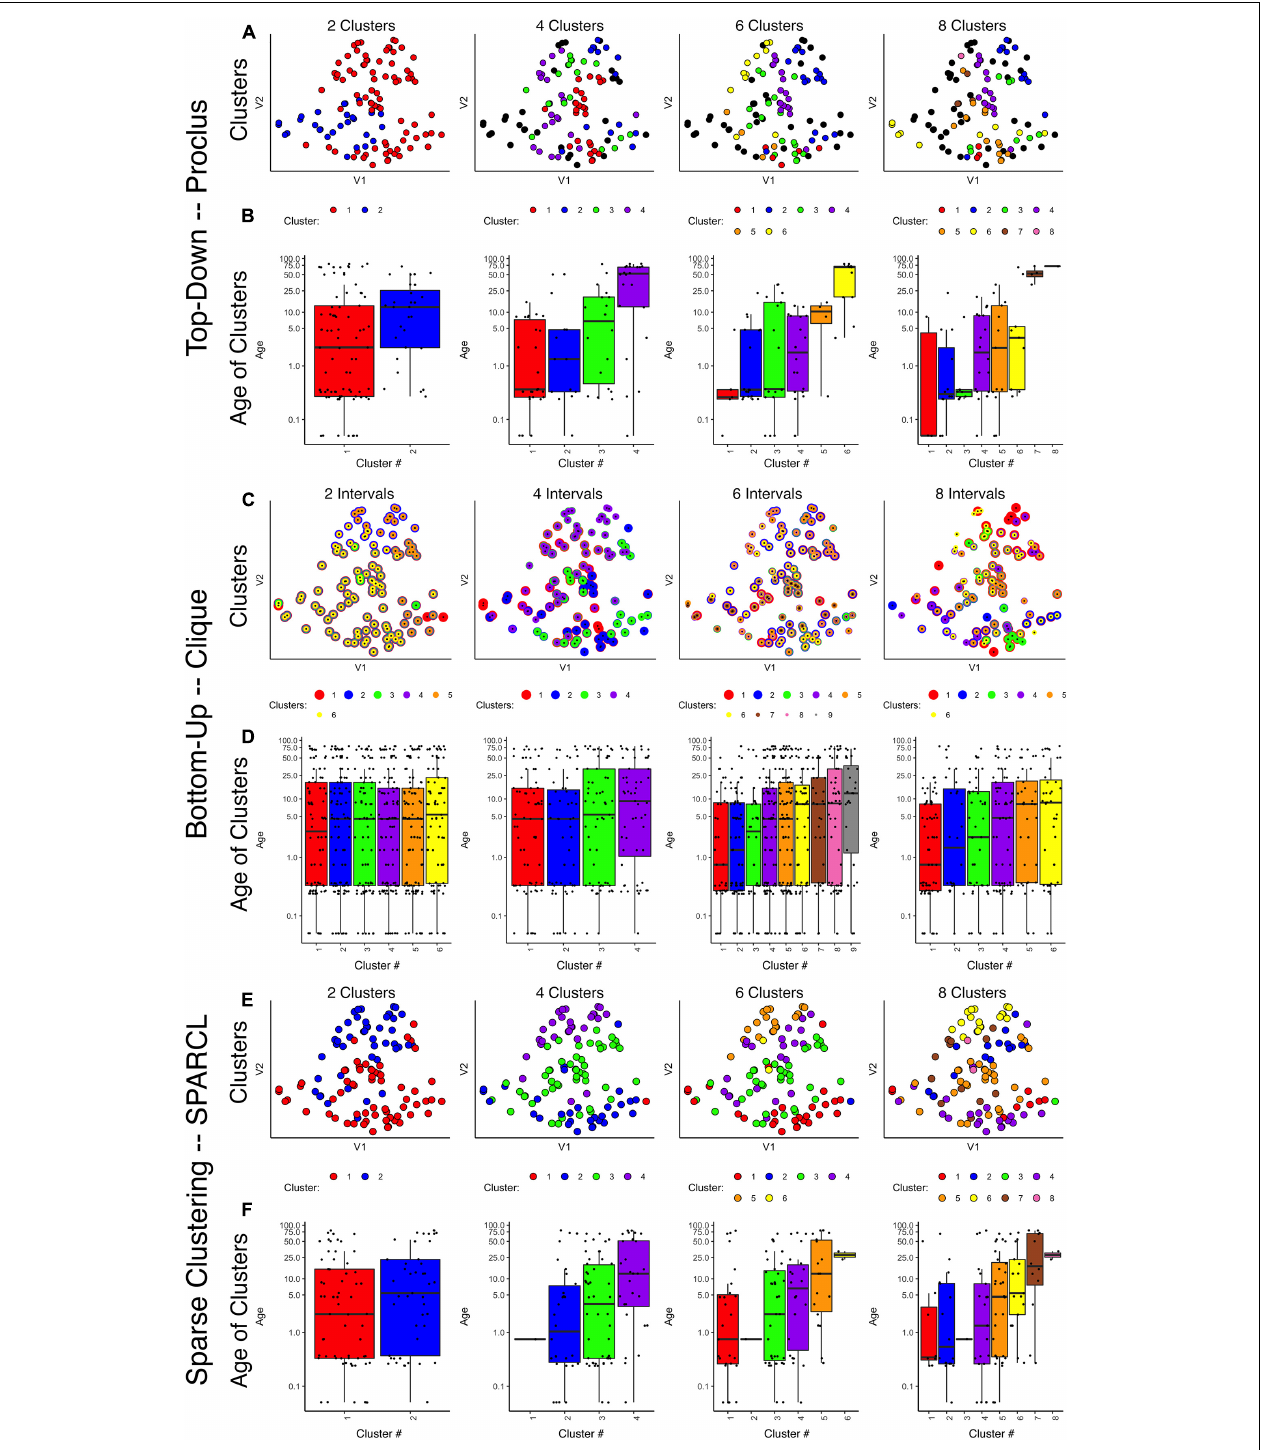
FIGURE 3 | Comparison of various sparse clustering methods. Top-down PROCLUS subspace method across range of cluster numbers (2, 4, 6, and 8). The clusters are visualized in tSNE 2D scatter plots of the data by color-coding each data point with its cluster identity (A) and in boxplots showing the median age of the samples in each cluster (B) . (C,D) Bottom-up CLIQUE subspace clustering method for a range of “intervals.” Different clusters are visualized as colored dots in a tSNE representation of the data (C) and as box plots depicting the mean age of the samples (D) . (E,F) Sparse clustering after varying the inputted k cluster number (2, 4, 6, and 8). Different clusters are visualized as colored dots in a tSNE representation of the data (E) and as box plots depicting the mean age of the samples (F) . The colors in scatter plots and boxplots represent the cluster designation for all plots.